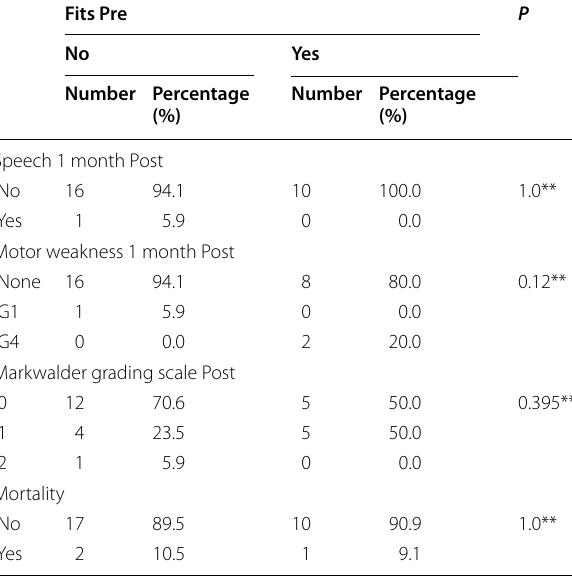
Table 13 Cases with and without preoperative convulsions compared regarding final study